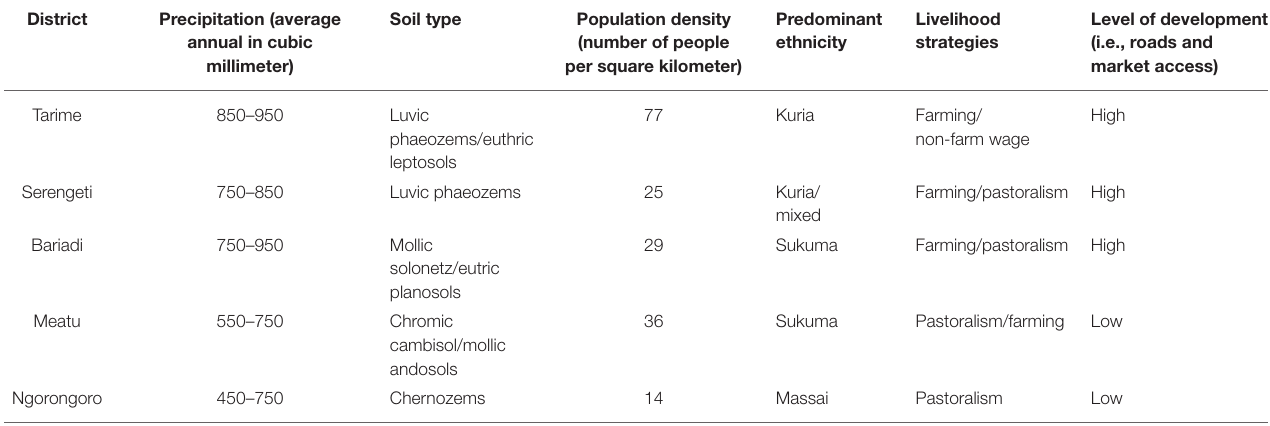
TABLE 1 | Socio-economic and biophysical characteristics of study districts. District Precipitation (average Soil type Population density Predominant Livelihood Level of development annual in cubic (number of people ethnicity strategies (i.e., roads and millimeter) per square kilometer) market access) 77 Kuria Farming/ High Tarime 850–950 Luvic non-farm wage phaeozems/euthric leptosols Serengeti 750–850 Luvic phaeozems 25 Kuria/ Farming/pastoralism High mixed